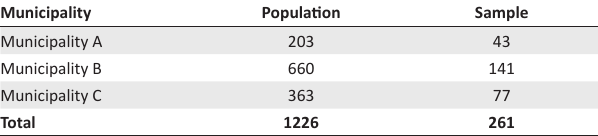
TABLE 1: Sample allocation of each municipality.